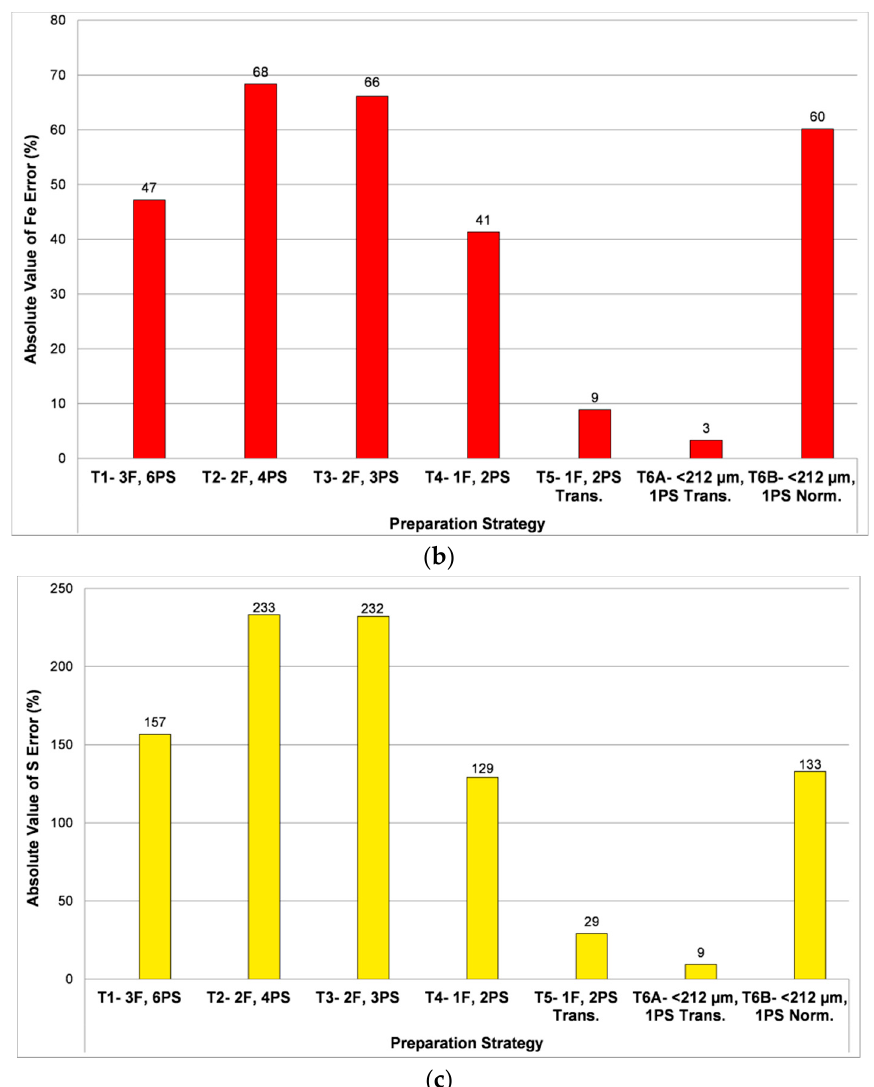
Figure 5. Average errors for ( a ) Cu, ( b ) Fe and ( c ) S calculated by calculating the difference between the QEMSCAN ® results for each of the sample preparation tests vs. chemical assays, and then computing the average for all three samples. T1: three size fractions with a total of six polished sections; T2: two size fractions with a total of four polished sections; T3: two size fractions with a total of three polished sections; T4: no size division, original and duplicate polished sections prepared; T5: no size division, two transverse polished sections prepared; T6A: granulometric size reduction